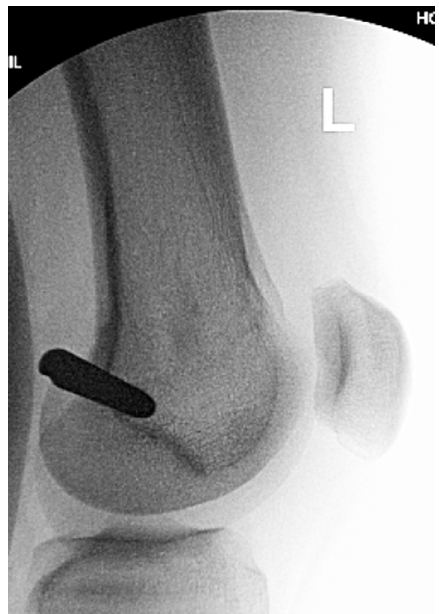
Figure 4. A 6 mm half pin is seen in the typical location posterior to the path of the ILN.